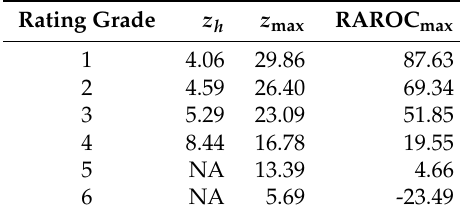
Table 6. Hurdle rate, maximum RAROC and z max for the unsecured installment loan Loan IV under the Internal Ratings Based Approach. All results are percentage